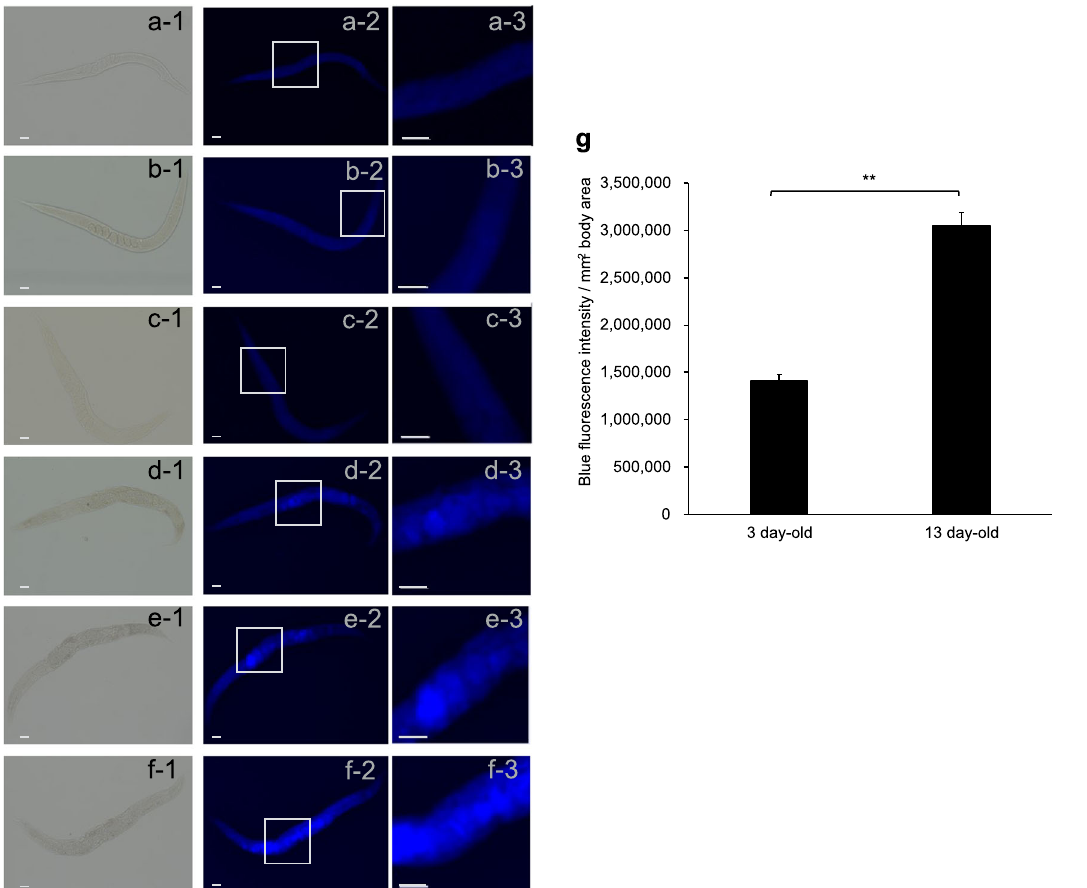
Fig. 7 Fluorescence images of 3-day-old and 13-day-old kynu-1 mutants. a – c Three-day-old worms and d – f 13-day-old worms, with raw images in column 1. To exclude the possible effects of death fl uorescence that starts from 2 days before the worms ’ demise, the mutant kynu-1 was used. Auto fl uorescence is seen in the images in columns 2 and 3. Photos in column 3 were magni fi ed from the indicated (by rectangles) areas of the images in column 2. Aged worms (13-day-old) auto fl uoresced signi fi cantly higher than young worms (3-day-old). Each scale bar indicates 50 μ m. g Quanti fi cation of blue fl uorescence using ImageJ and ImageQuant TL software. Each bar represents the average values of fl uorescence intensity per 1 mm 2 of nine worms. ** indicates a statistically signi fi cant difference between 3-day-old and 13-days worms at a p value < 0.01. Error bars represent the